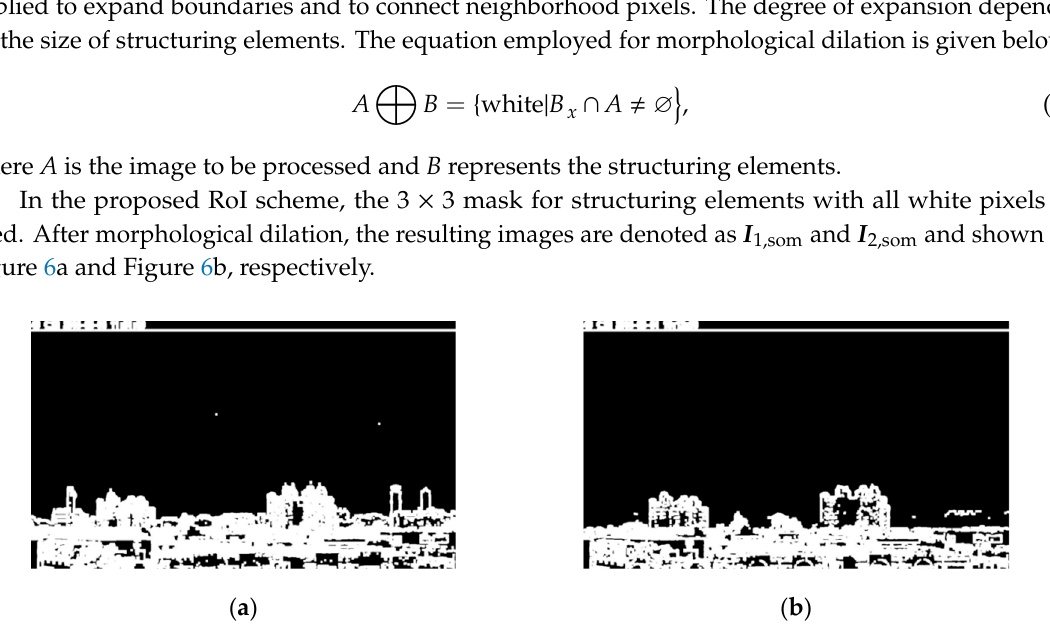
Figure 6. Images after morphological dilation. ( a ) I 1,som (low PM 2.5 concentration); ( b ) I 2,som (high PM 2.5 concentration).